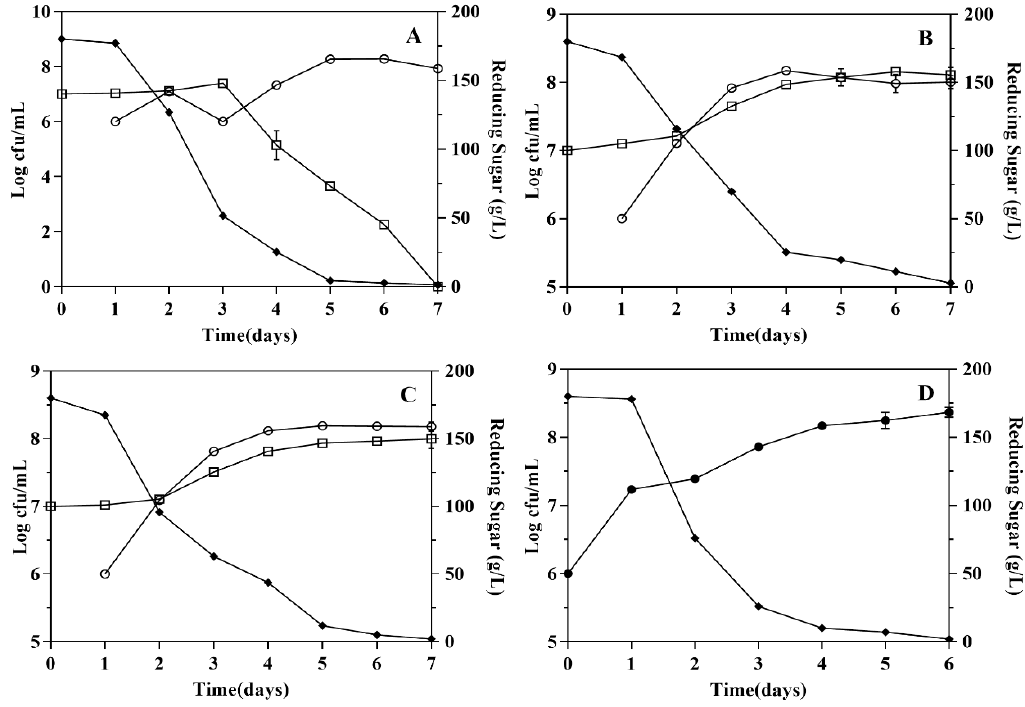
Figure 1. Growth kinetics and sugar consumption kinetics of yeast strains during fermentations. ( A , B and C are co-fermentation with S. cerevisiae , and D is pure culture). A . H. uvarum ; B . T. delbrueckii ; C . H. opuntiae ; D . S. cerevisiae . - (cid:3) - Growth kinetics of non- Saccharomyces in co-fermentations - (cid:7) -